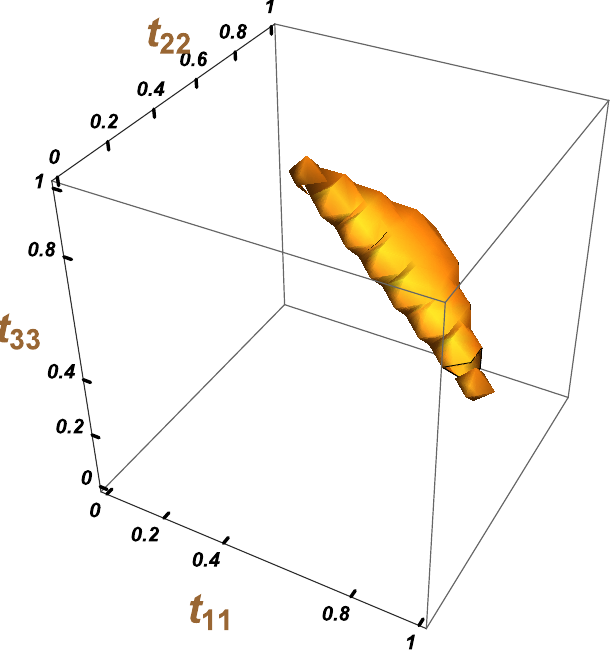
Figure 5: Shaded region forms a part of singular value space of correlation tensor of an arbitrary two-qubit state. State corresponding to any point from this region is useless in CHSH- based QKD protocol whereas the same is useful in our protocol.